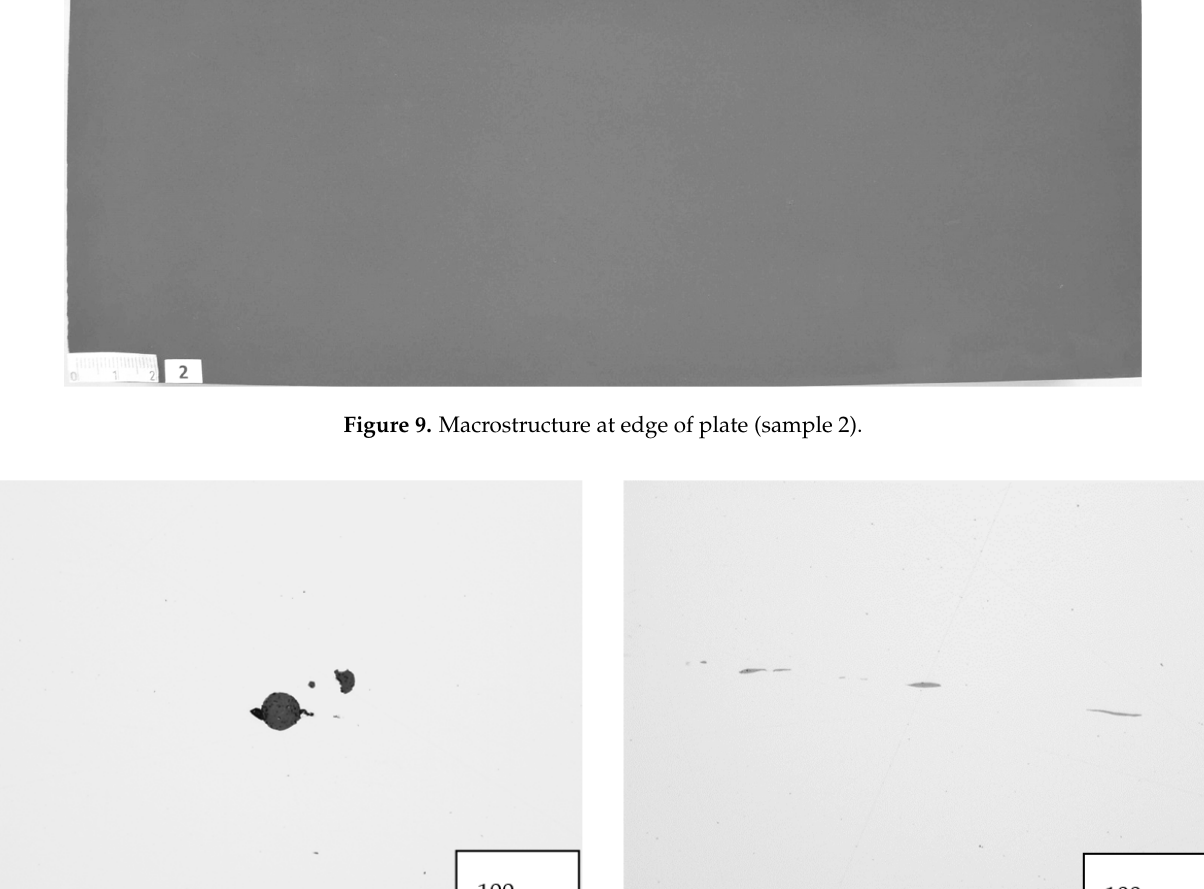
Figure 9. Macrostructure at edge of plate (sample 2).